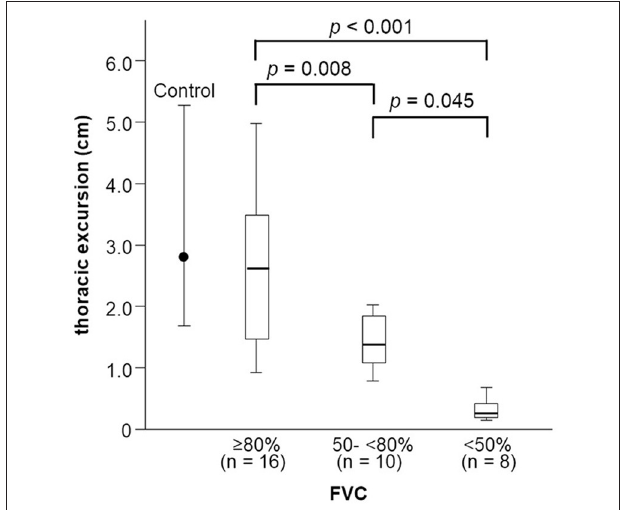
FIGURE 5 | Changes in thoracic excursion with FVC decline. Thoracic excursion decreases in both the early and late stage of FVC decline in patients with ALS. FVC, forced vital capacity; ALS, amyotrophic lateral